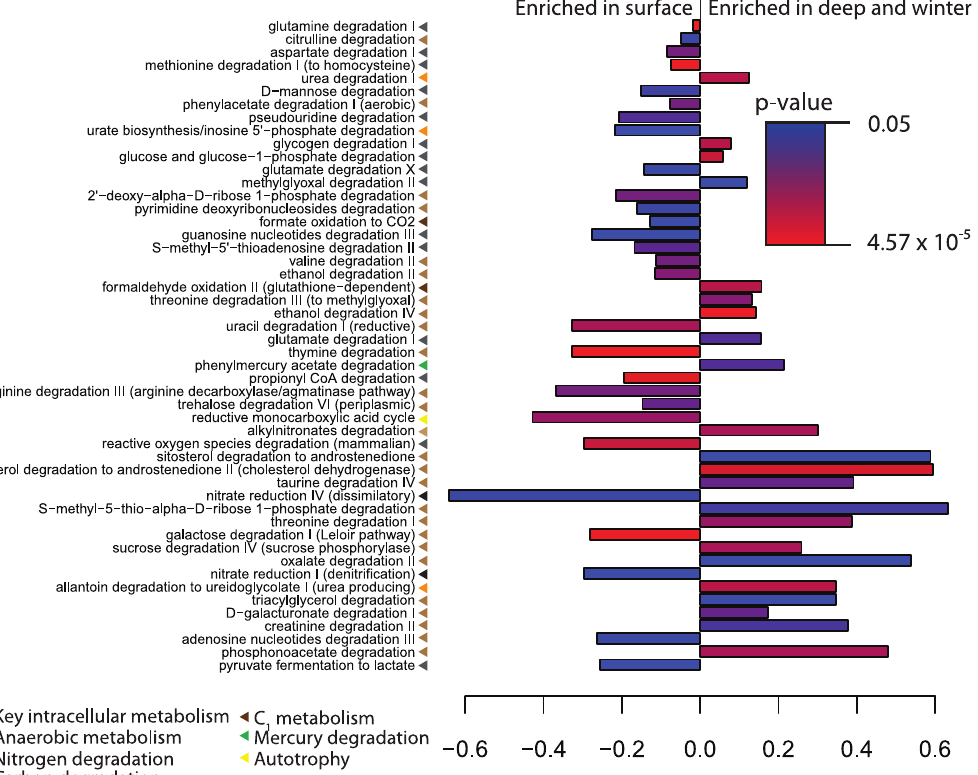
Fig 6. Metabolic pathways differentially present between summer surface samples and winter and deep samples. Color gives the p-value for a Mann- Whitney test between sample groups. X-axis gives the anomaly, calculated as the difference in sample group means divided by the sum of the sample group